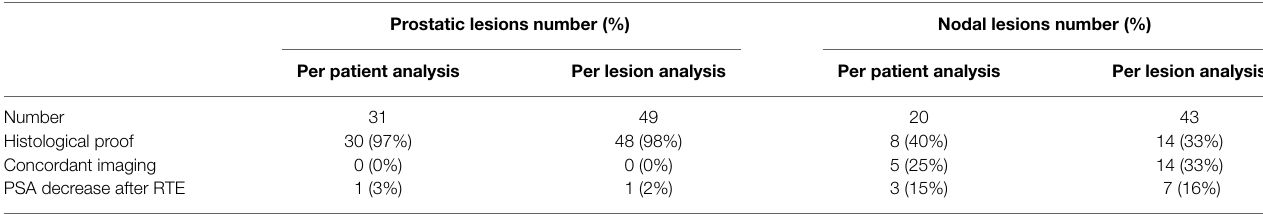
TABLE 2 | Description of lesion characteristics ( n === 92) in the 39 patients